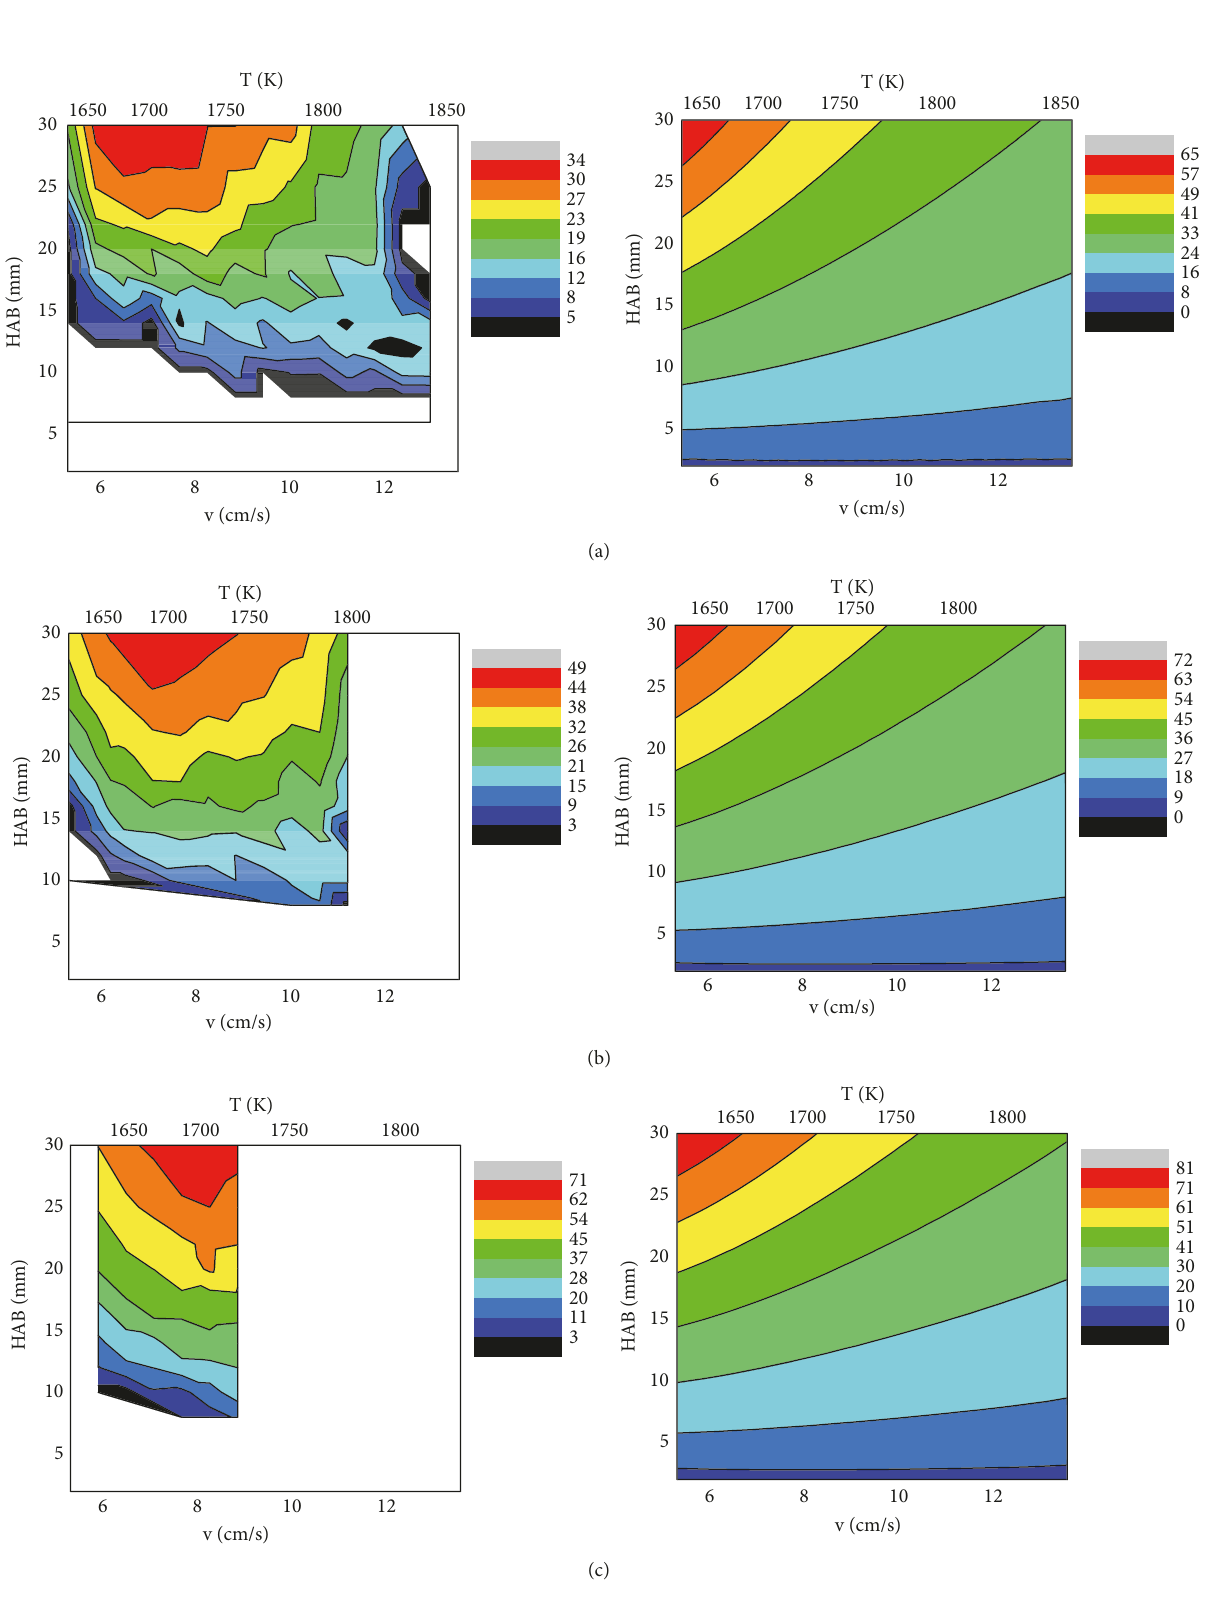
Figure 9: Contour plots of the measured (left) and calculated (right) radius of gyration (nm) as function of HAB and exit velocity V for equivalence ratios (a) 𝜙 = 2.1, (b) 𝜙 = 2.2, and (c) 𝜙 = 2.35. Only the computations using the model of Leung et al. [19] are shown (see